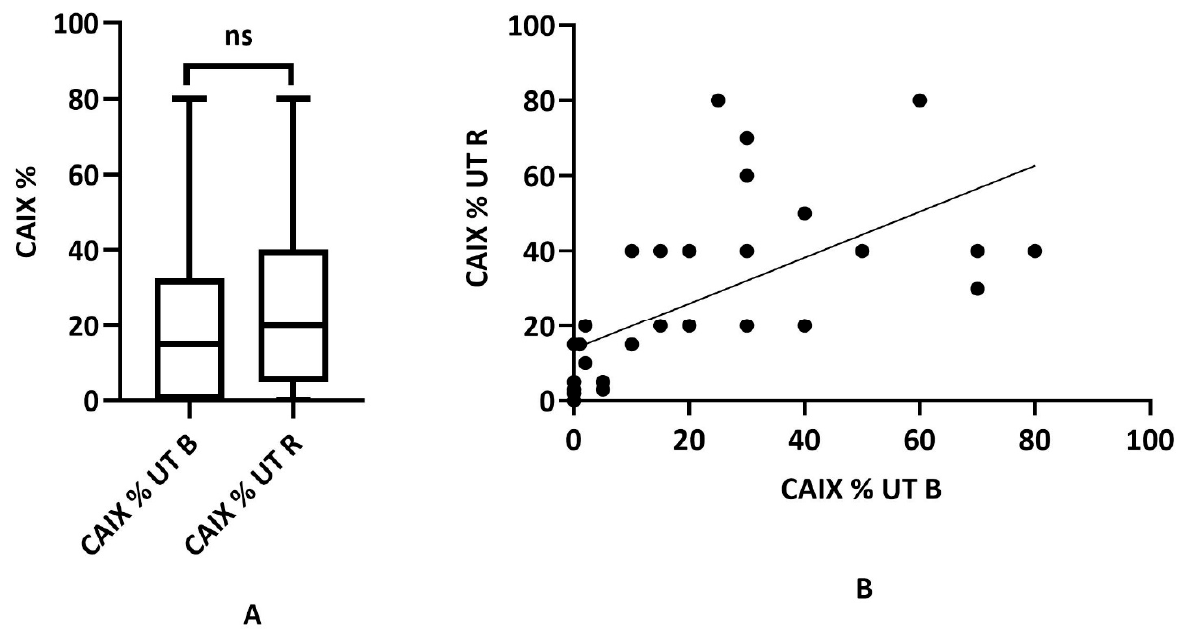
Figure 5. Distribution of CAIX expression in untreated biopsies (UT B) and matching surgical resection samples (UT R) ( n = 34). ( A ) The range of CAIX tumor labeling was 0–80% for both sample types, but a significant difference is not provided (mean 15.0 ± 21.3 SD vs. 20 ± 23.02, p = 0.073, ns: statistically not significant); ( B ) correlation between UT B and UT R CAIX expression in the UT cancer group ( p < 0.0001, rho: 0.8077). Table 2. Statistical distribution of CAIX expression concerning clinicopathological parameters of untreated (control) rectal adenocarcinoma